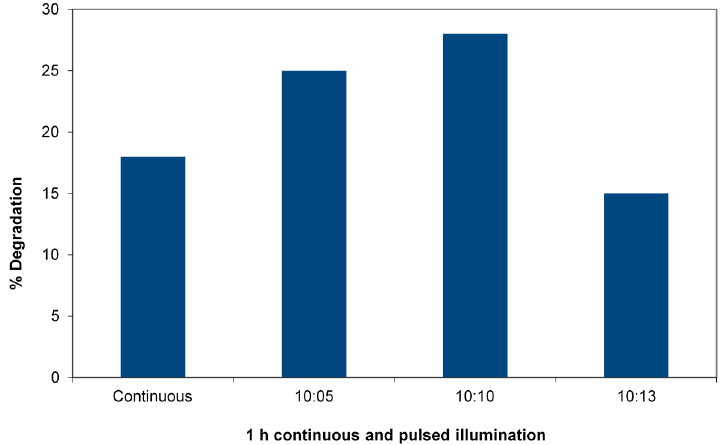
Figure 4. Pulsed vs . continuous irradiation in a 365-nm LED reactor degrading 4-chlorophenol (4-CP). Charge is 0.05 g WO 3 /TiO 2 and 5 mL of 33 mg/L 4-CP receiving (4.3 ± 0.2) × 10 16 photons/s. Total irradiation: 60 min in each case, duty cycle (ratio minute light:minute dark)